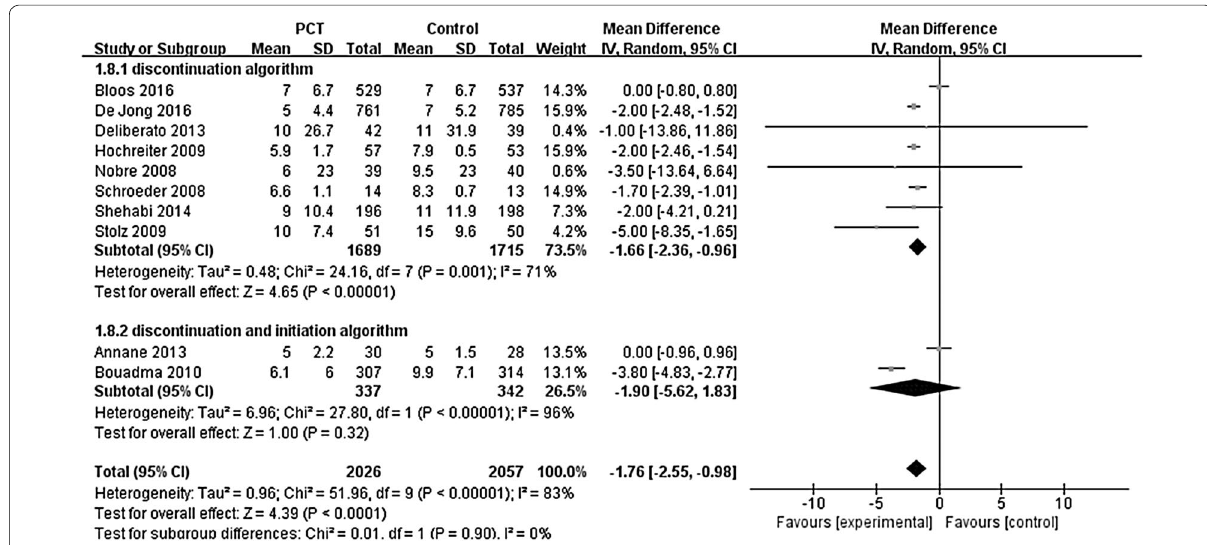
Fig. 2 Effects of PCT‑guided antimicrobial strategies on total days of antibiotics